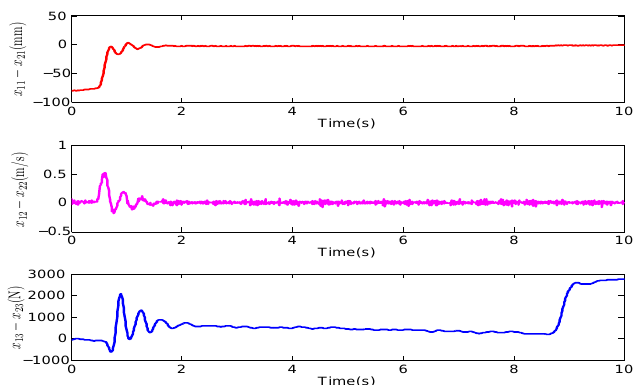
x 21 (the red line)—the − x 23 (the blue −